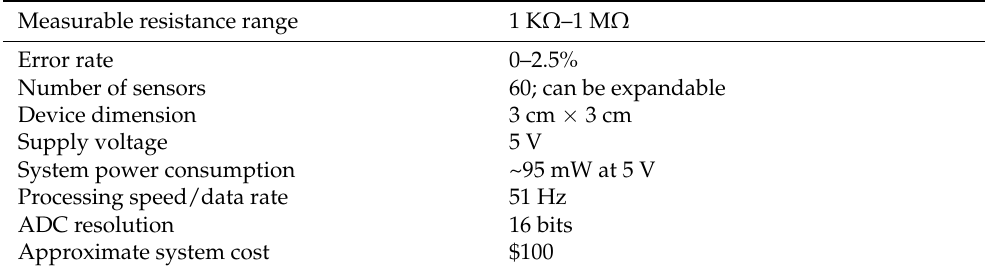
Table 5. System performance